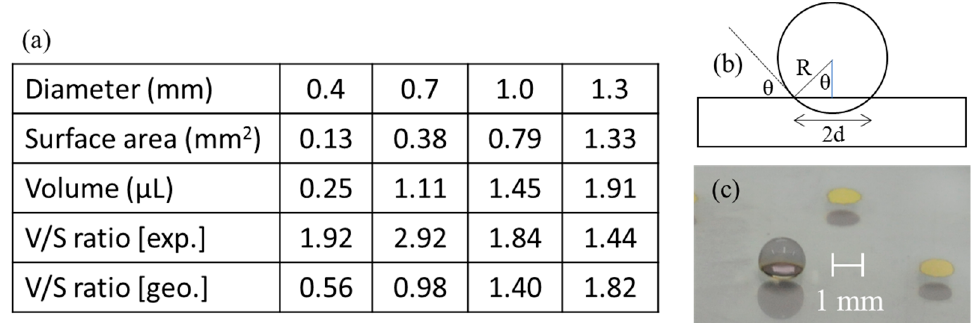
Figure 1. Photos of 1 µ L water droplets placed on various surfaces. ( a ) plane glass slide as delivered, ( b ) glass slide treated with decyltrimethoxy silane (DCTMS), ( c ) glass slide covered by a monolayer of silica nanospheres, ( d ) glass slide covered by a monolayer of silica nanospheres after the DCTMS treatment, and ( e ) the substrate from ( d ) after deposition of 100 nm silver. The contact angle was the smallest, less than 5 degrees, for ( a ) and the largest at 150 degrees for ( d ). By depositing silver on the monolayer of DCTMS treated silica nanospheres, the surface became less hydrophobic ( e ), but at the boundary between the areas with / without silver deposition, the contact angle was 130 degrees ( f ).